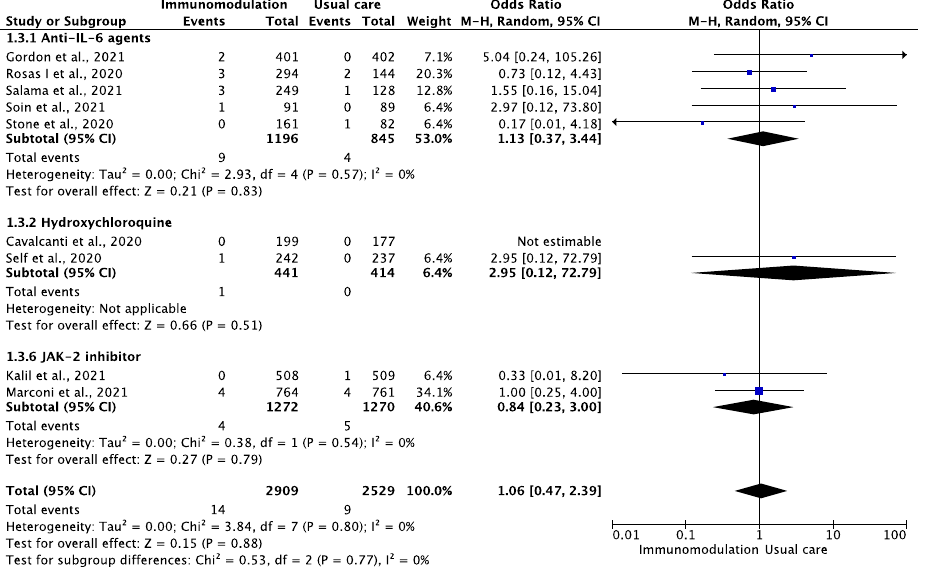
Figure 3. Odds ratio (OR) and 95% confidence intervals for the occurrence of myocardial infarction among the hospitalized COVID-19 patients prescribed immunomodulatory agents as an add-on to SOC vs. SOC only. Boxes represent the OR and lines represent the 95% CIs for individual studies. The diamonds and their width represent the pooled ORs and the 95% CIs, respectively. CI, confidence interval for the Mantel–Hansen estimator, I 2 :